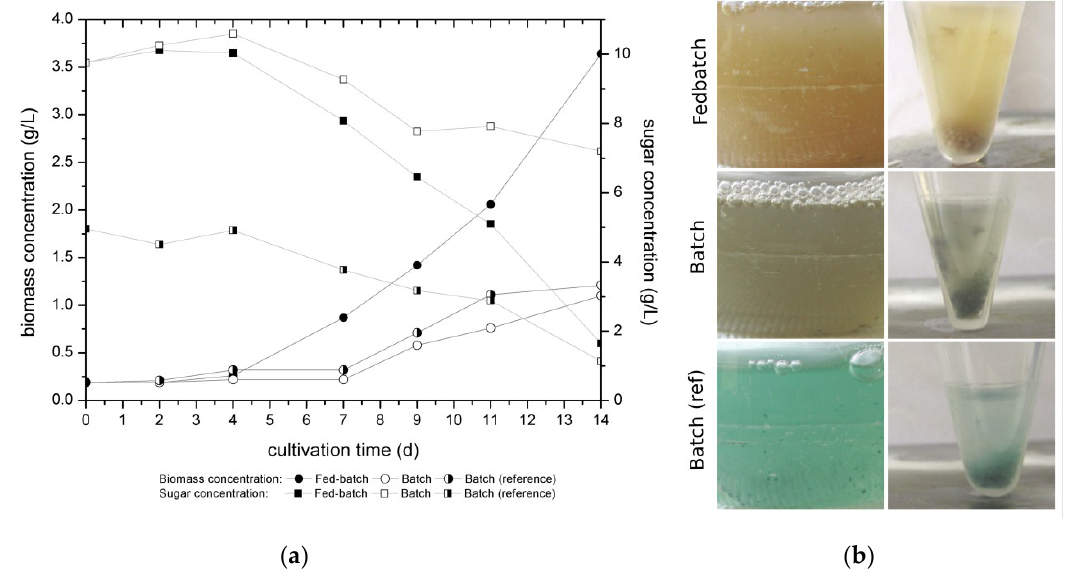
Figure 4. ( a ) Concentration of dried biomass and reduced sugars during the liquid cultivation of Chlorociboria aeruginascens as fed-batch (fed at day: 4, 7, 9, 11) and batch cultivation with the initial medium containing 10 g / L glucose and 0.5 g / L yeast extract (defined medium); as reference medium 5% orange juice was used for the batch (reference) cultivation ( n = 4). ( b ) Appearance of the pigmentation in flask (left column) and of the centrifuged biomass (right column) after 14 days of cultivation.